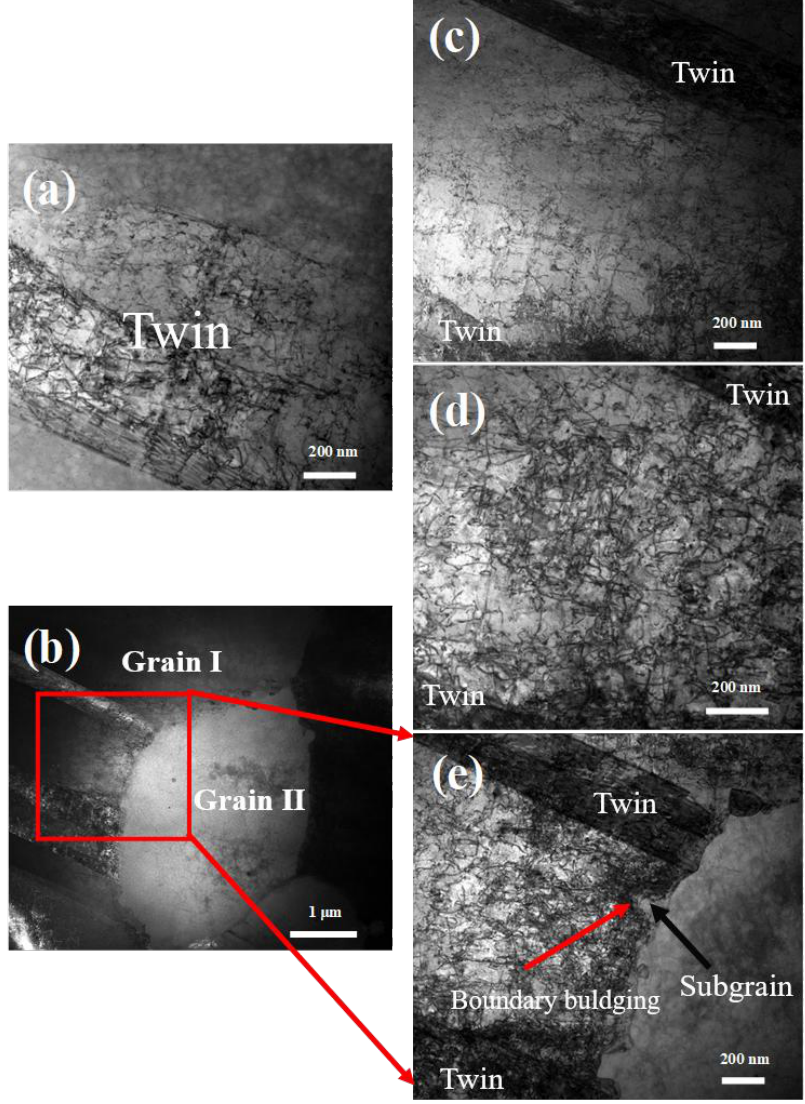
Figure 6. TEM images of FGH96 alloy after hot deformation at 1150 °C to a strain of 0.5; ( a ) dislocation distribution inside the twins; ( b ) two different size grains (grain I and grain II); ( c ) dislocation distribution inside the grain I; ( d ) dislocation distribution close to grain I boundary; ( e ) is a magnification of the region in ( b ) marked by red rectangular.